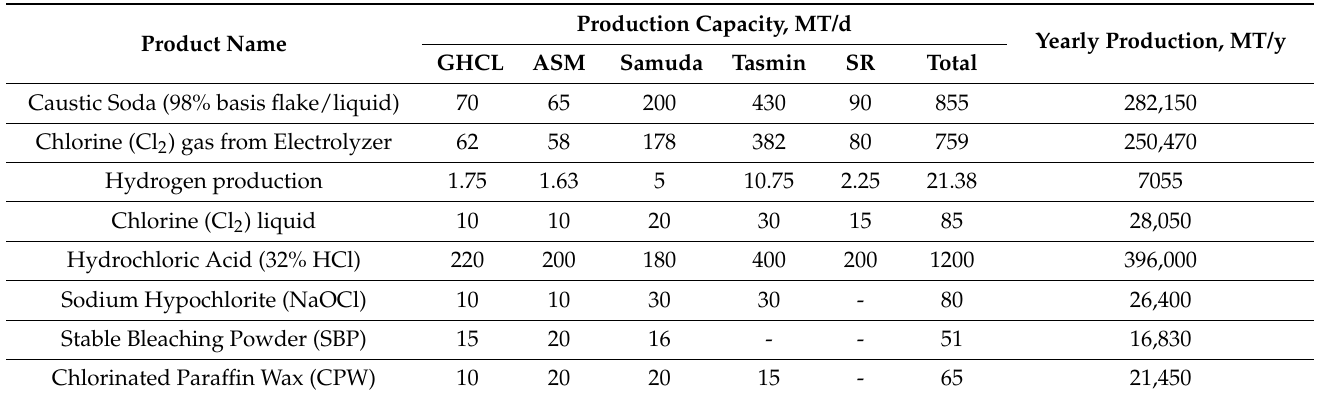
Table 2. Production capacity of different chlor-alkali plants in Bangladesh.